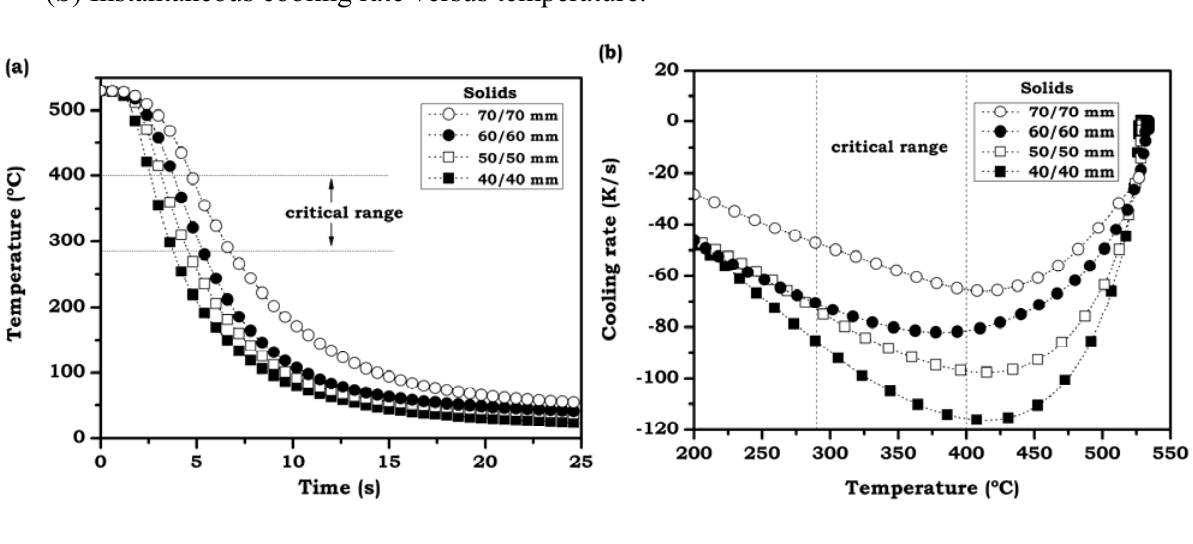
Figure 6. Quenching curves for the solid samples: ( a ) Registered temperature variation; ( b ) Instantaneous cooling rate versus